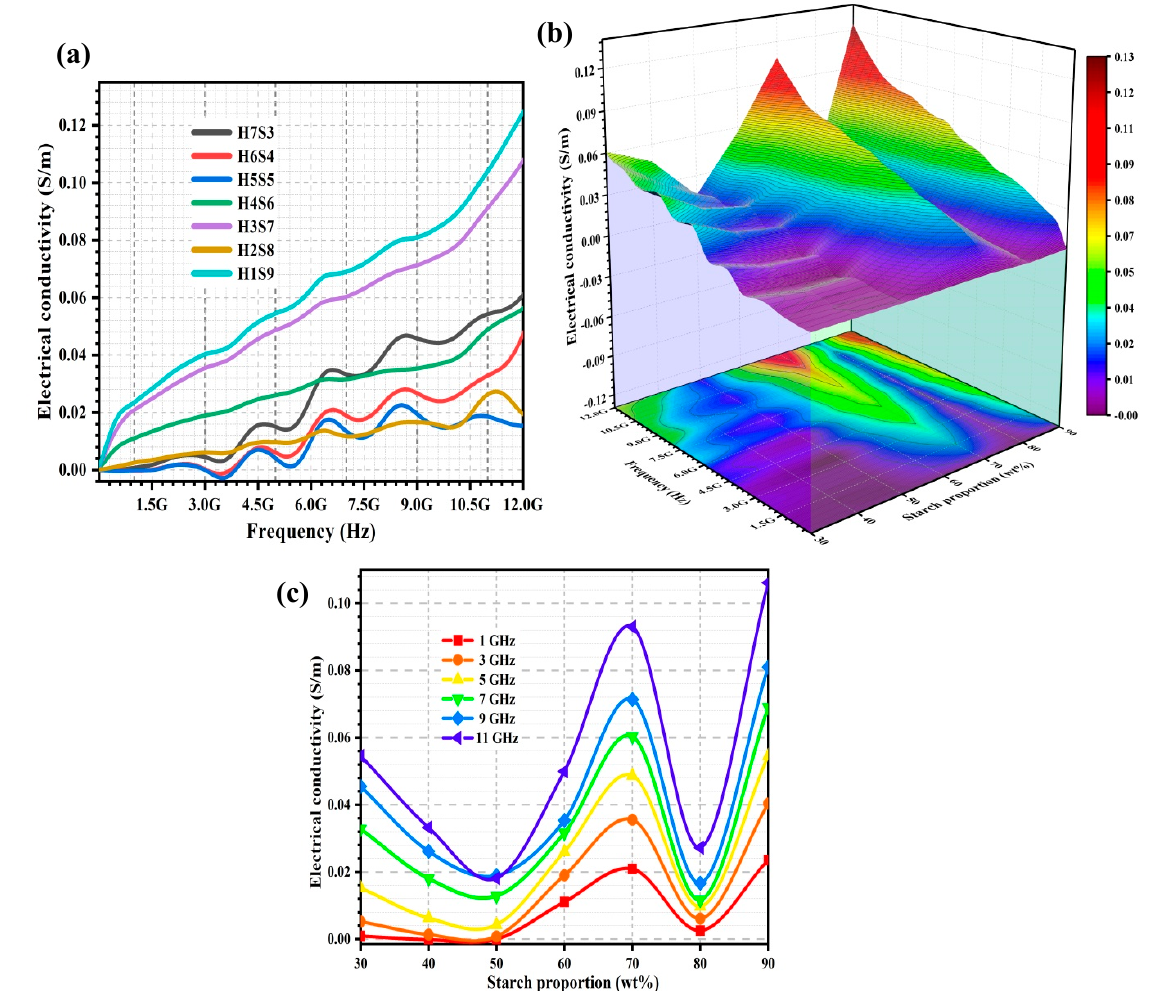
Figure 6. The σ spectra ( a ) of the porous nHA/S composites. Three-dimensional representation of σ of the porous nHA/S composites ( b ). The σ curves of the porous nHA/S composites at varied selected frequencies ( c ).